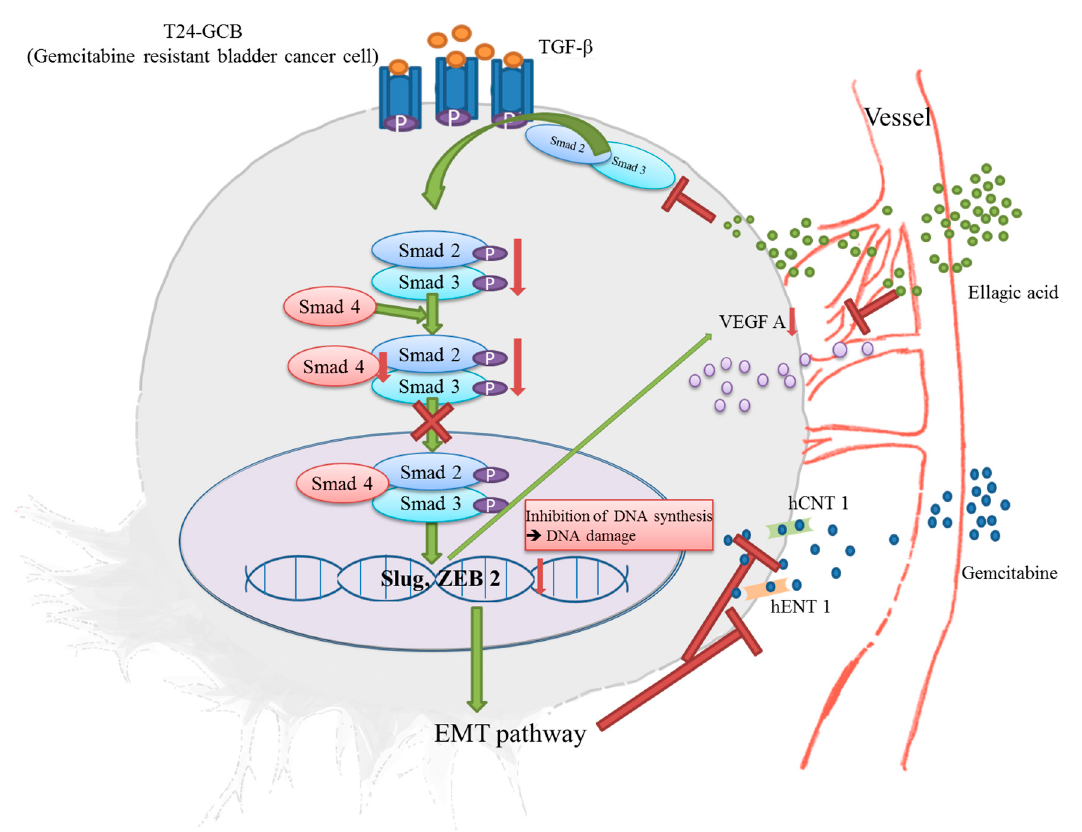
Figure 6. Schematic diagram of EA combined with GCB regulating the EMT process in GCB-resistant bladder cancer cells. Supplementary Materials: The following are available online at www.mdpi.com/xxx/s1, Figure S1: